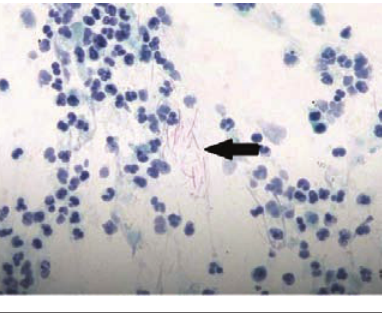
Figure 2. Papanicolaou stain of the bronchial washing reveals the elongated bacilli (arrow). Magnification 400 ¥